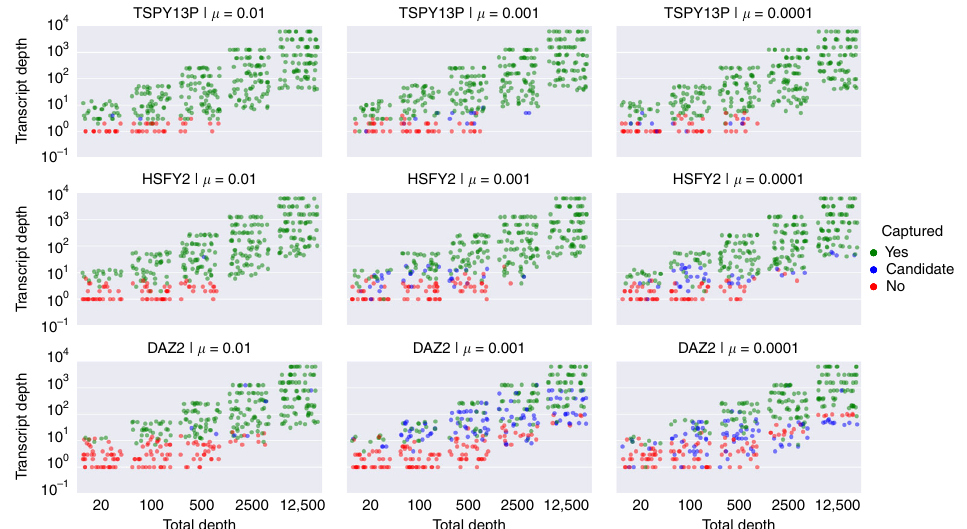
Fig. 2 Power of IsoCon to capture transcripts. Each isoform from the experiments in Supplementary Figure 1 (including the 10 simulated replicates) corresponds to a marker in this plot which is marked according to whether it is captured and output as a fi nal prediction (green), derived in the error correction step but fi ltered out in the statistical step (blue) or not produced at all in the correction phase (red) by IsoCon. This is a stripplot generated with the seaborn package 64 , which is a special kind of dotplot where the x -axis is categorical (total number of reads of the corresponding experiment) and points are spread out horizontally. The y -axis shows the number of reads that were sequenced from the isoform, on a log scale. Isoforms that have no reads are not shown Table 2 The number of reads and predicted transcripts. We show: (1) maximum RT-PCR product length per family (including primers), (2) the number of original PacBio CCS reads, with the number of distinct read sequences in parentheses, (3) the number of Illumina reads, (4) the number of distinct proovread Illumina-corrected CCS reads, (5) the number of ICE-predicted transcripts, and (6) the number of IsoCon-predicted transcripts. We use s1 and s2 to indicate sample 1 and sample 2,